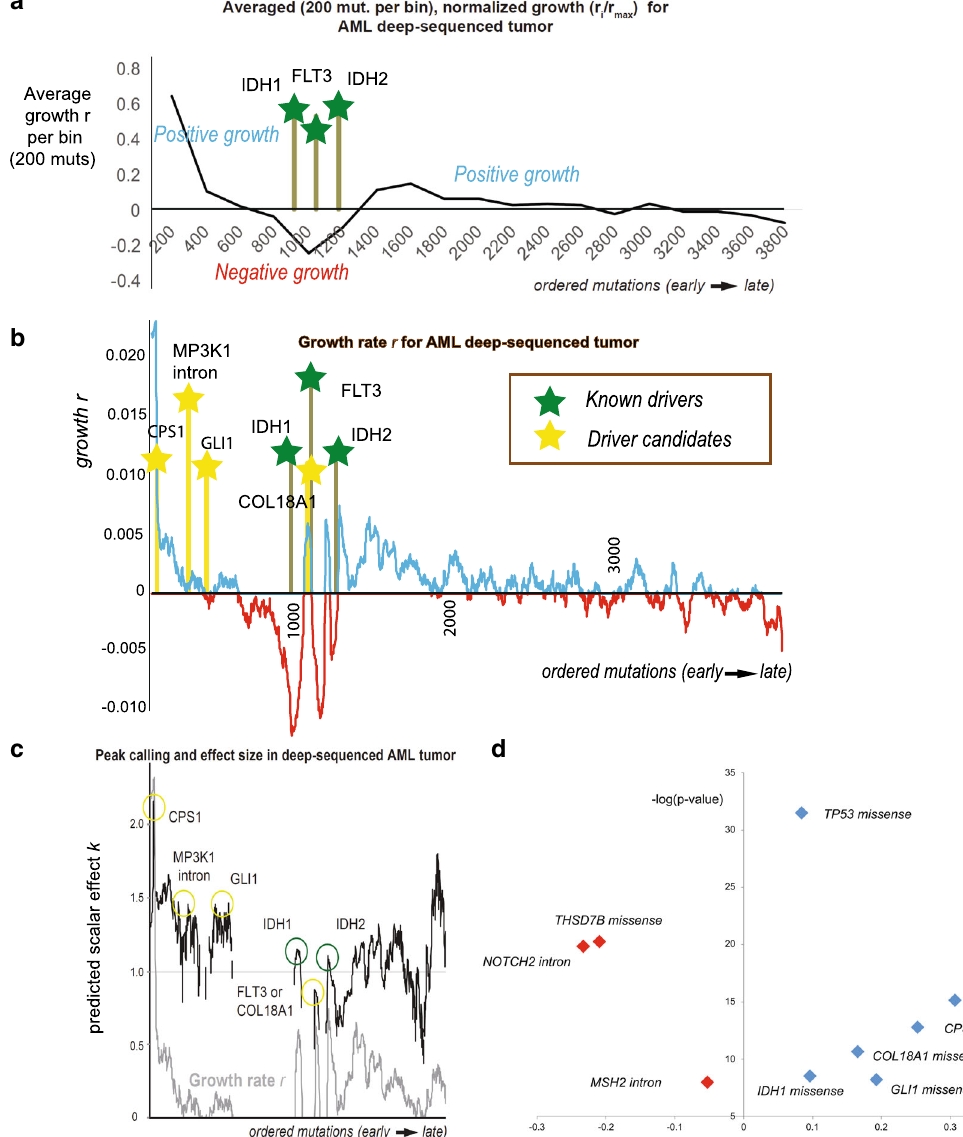
Fig. 5 Tumor progression on model AML liquid tumor. In a , we show the averaged growth progression for an AML ultra-deep-sequenced tumor. We ordered the sample ’ s mutations from highest to lowest frequency and divided them into bins of 200 mutations. Three cancer mutations hit the tumor to establish a permanent growth (cancer mutations denoted by green bars). In b , we plot the mutational growth r i − 1 for each mutation across tumor progression. The three cancer genes ( IDH1 missense, FLT3 missense, and IDH2 missense) aligned well with 3 of our top 5 growth peaks (two-tailed t test p < 2.2e − 16). Candidate driver mutations -denoted by yellow bar — that we identi fi ed from our PCAWG database as being associated with positive growth (see also “ (d) ” ) aligned well with early — previously unjusti fi ed growth peaks. In c , we show each mutation ’ s effect in tumor progression. Effect peaks corresponds to putative drivers. d By using our PCAWG database from our previous analysis, we tested which mutations from the deep-sequenced sample were associated with positive growth. The x -axis represents positive growth enrichment, while the y -axis shows the level of signi fi cance as the negative logarithm of a two-tailed t test p value ( − log( p value) > 5. Overall, we found 6 mutation types that showed signi fi cant positive enrichment across 993 PCAWG tumors, including TP53 missense (appeared during metastasis), IDH1 missense, COL18A1 missense, CPS1 missense, GLI1 missense, and SRCAP missense. Missense TP53 and SRCAP mutations are not included in graph (b) as they were metastatic mutations. For association with positive growth we tested all missense mutations (e.g., CPS1 missense), and every mutation in the sample from Vogelstein cancer genes (e.g., NOTCH2 coverage, tumor ploidy, subclonality, and a low number of tumor samples per cancer or mutational element. Under a neutral model, our method would still detect some growth peaks or suggest the presence of weak drivers. These are false-positive